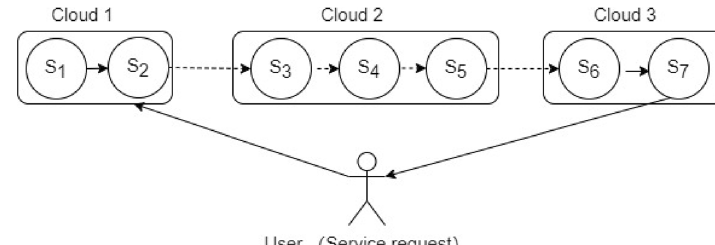
Fig. 3 Energy consumption model for the multicloud